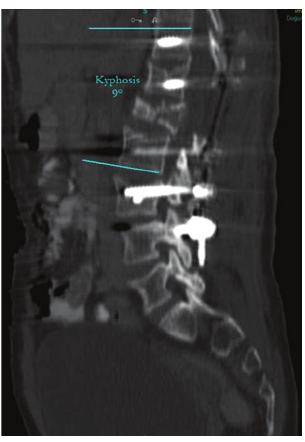
Figure 3: Postoperatively, the measured T12–L2 local kyphotic angle.